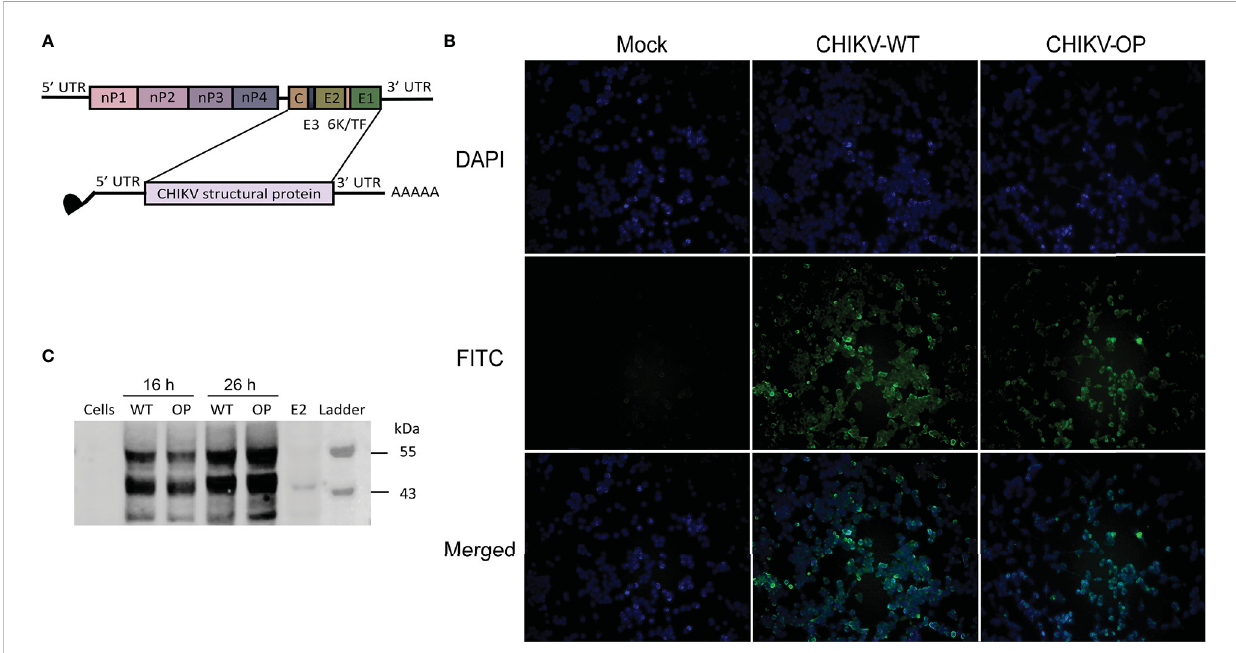
FIGURE 1 Design and protein expression of the CHIKV mRNA vaccine. (A) Schematic of the CHIKV genome structure and mRNA construct. (B) Structural protein expression following mRNA transfection with wild-type (WT) or codon-optimized (OP) mRNA as determined using FITC immuno fl uorescence staining (scale bar, 400 m m). (C) Western blot analysis of structural protein expression from CHIKV mRNA-WT or -OP in DC 2.4 cells and lysate at 16 or 26 h post-transfection. E2, control structural